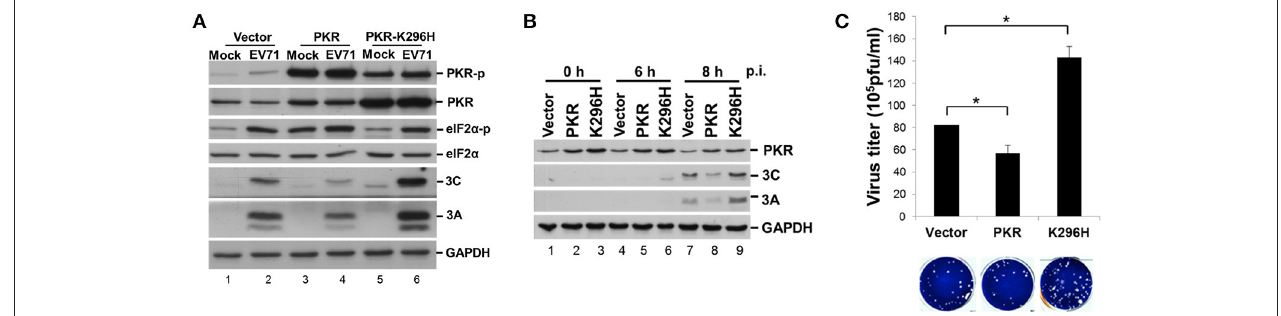
FIGURE 5 | Expression of a PKR kinase-dead mutant results in an increase of viral proteins and virus titer. (A) RD cells were transiently expressed with PKR or the K296H mutant for 24 h, and then infected with EV-A71 at an m.o.i. of 10. Immunoblot analysis was performed for detecting the presence and phosphorylation of PKR (anti-PKR, anti-PKR-p) and eIF2 α (anti-eIF2 α , anti-eIF2 α -p), and the expression of viral 3A and 3C proteins. GAPDH expression was used as a protein loading control. A representative result from three independent experiments is shown. (B) Stable RD cells expressing vector alone, PKR, or K296H were selected by addition of 3 µ g/mL puromycin. Cells were infected with EV-A71 at an m.o.i. of 10 and then the cellular extracts were harvested at 0, 6, and 8 h post-infection. Immunoblot analysis was performed to detect the presence of PKR and viral 3A and 3C proteins. A representative result based on three independent experiments is shown. (C) RD cells stably expressing PKR or the K296H mutant were infected with EV-A71 at an m.o.i. of 10 of for 8h. The RD cells and culture supernatant were harvested for virus titer determination by plaque assay. The results are expressed as the mean ± SD ( n = 3). * p < 0.05.